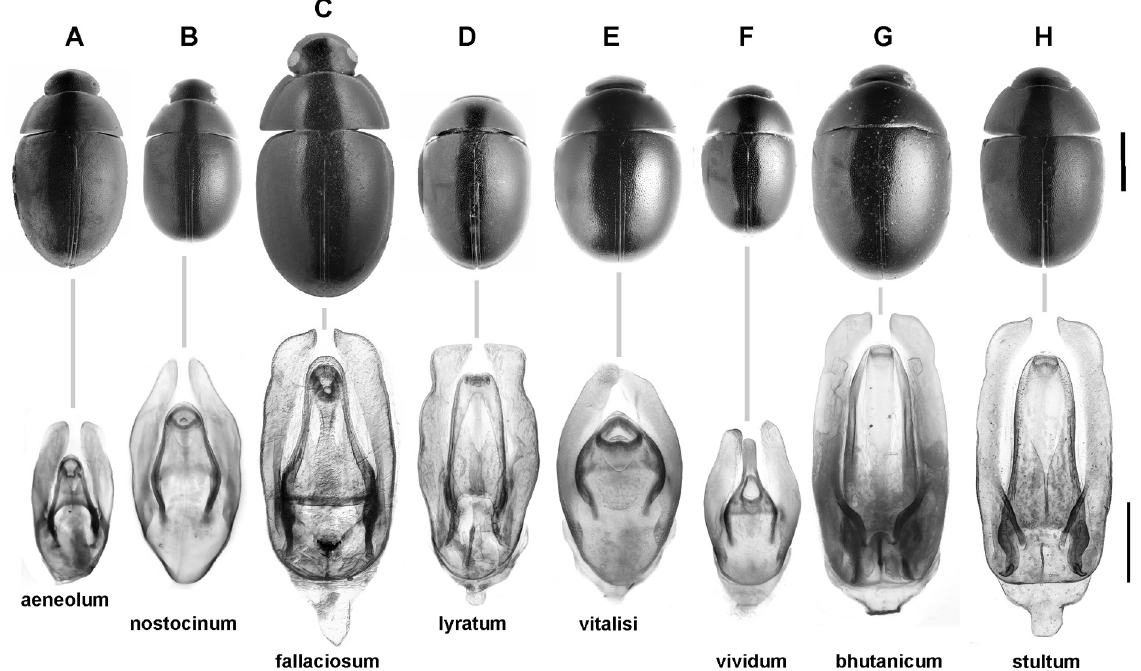
Fig. 2. Overview of Coelostoma Brullé, 1935 s. str. and Holocoelostoma Mouchamps, 1958 of the Indian subcontinent (habitus on the top, aedeagus on the bottom). – A–F . Coelostoma s. str. A . C. aeneolum Régimbart, 1903. B . C. nostocinum sp. nov. C . C. fallaciosum Orchymont, 1936. D . C. lyratum sp. nov. E . C. vitalisi Orchymont, 1923. F . C. vividum Orchymont, 1936. – G–H . Holocoelostoma . G . C. bhutanicum Jayaswal, 1972. H . C. stultum (Walker, 1858). All habitus figures and all aedeagi are to scale. Scale bars: habitus = 1 mm; aedeagus = 0.25